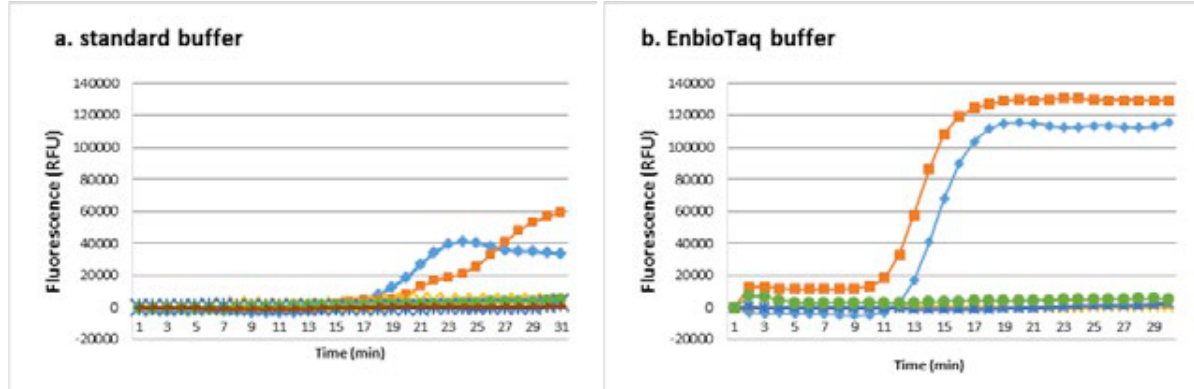
Figure 4. Comparison of real-time LAMP reaction in detecting Xf with the standard buffer (a) and with the EnbioTaq buffer (b). In both trials DNA was extracted using the rapid extraction method. Samples were tested in SMART-DART